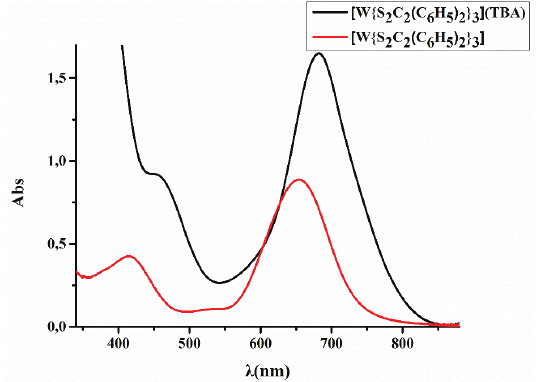
C (Ph) } ] ( 1 ) (0.04mM) 2 2 2 3